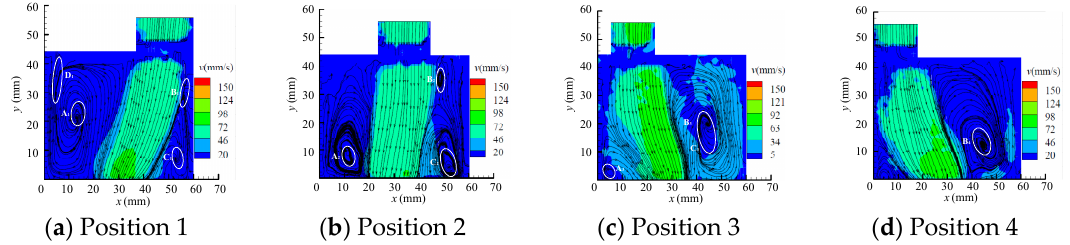
Figure 17. Velocity contours and streamlines with a piston moving speed of 3.7 mm/s.